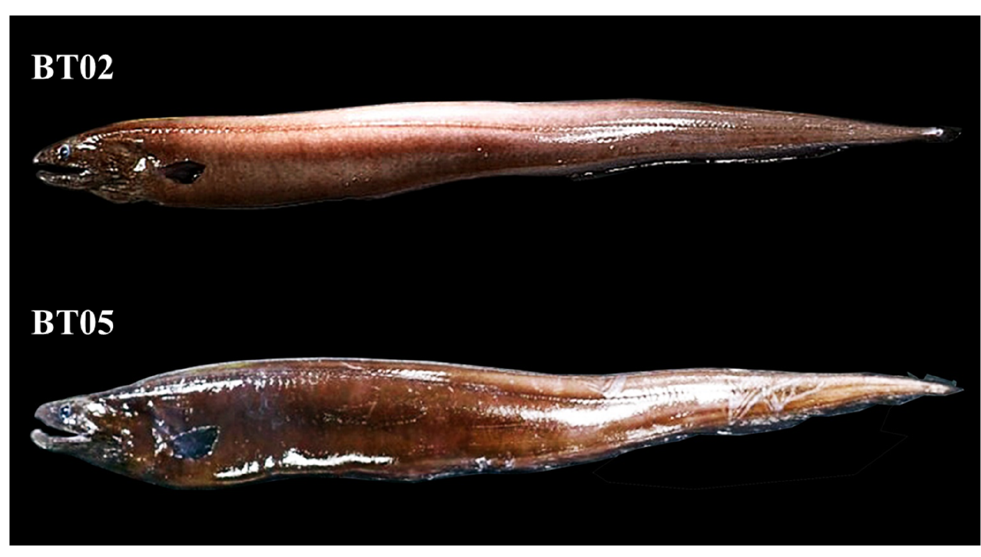
Figure 2. Picture of the two deep ‐ sea Synaphobranchus eels. Table 2. Morphometric characters of the two eel specimens collected from the East Mariana Basin, western Pacific